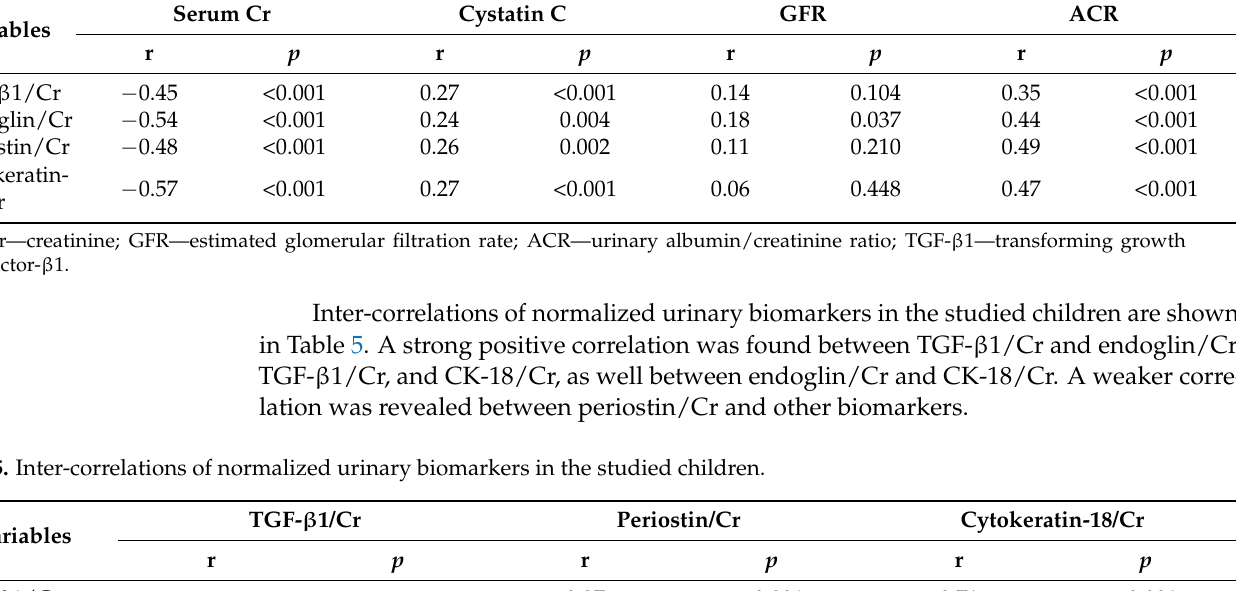
Table 4. Correlations between urinary biomarkers and laboratory indices of kidney injury in the studied children. Variables